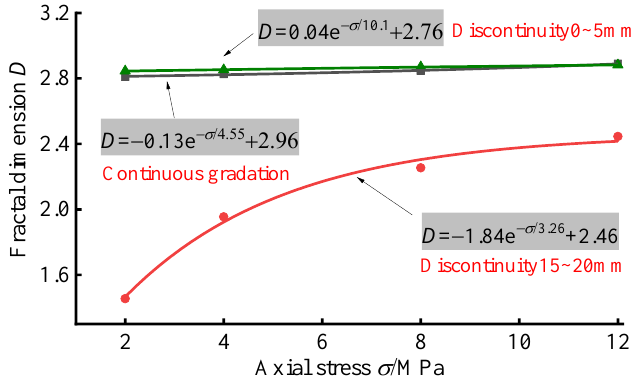
Figure 9. Fractal dimension versus axial stress curve.